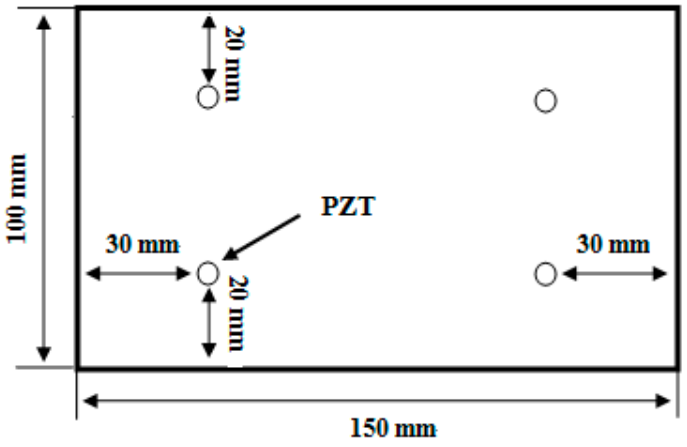
Figure 11. The schematic diagram of the PZT positions on the specimen used for damage detection validation.